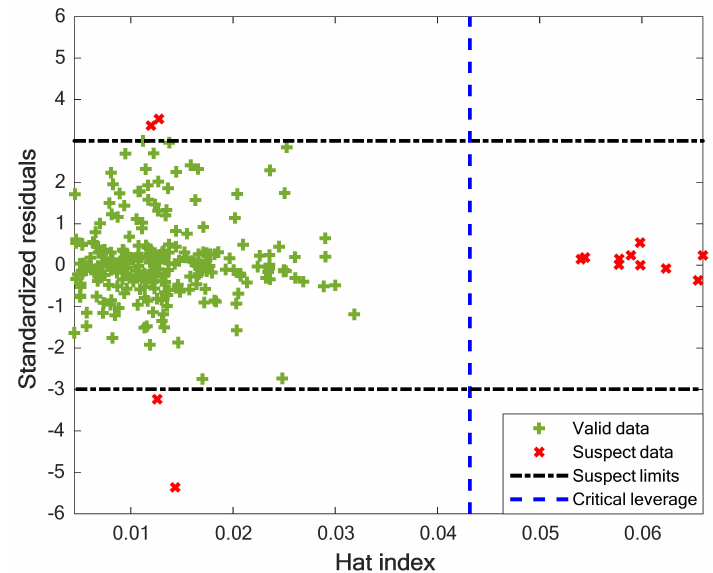
Figure 8. William’s graph to identify outlier as well as valid